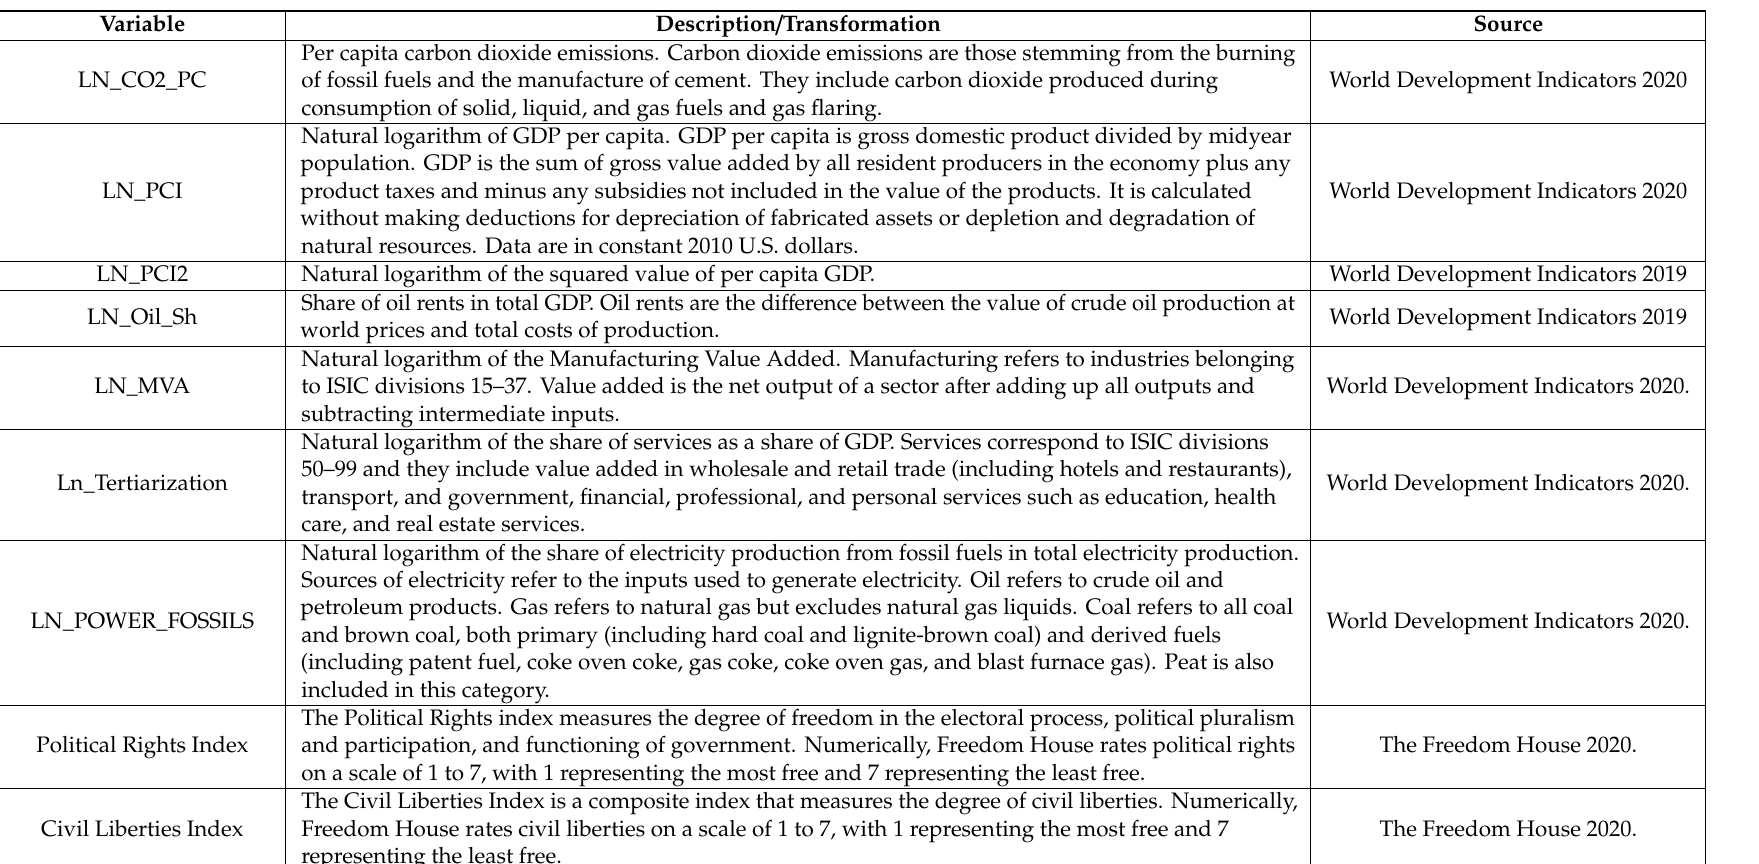
Table 1. Description of